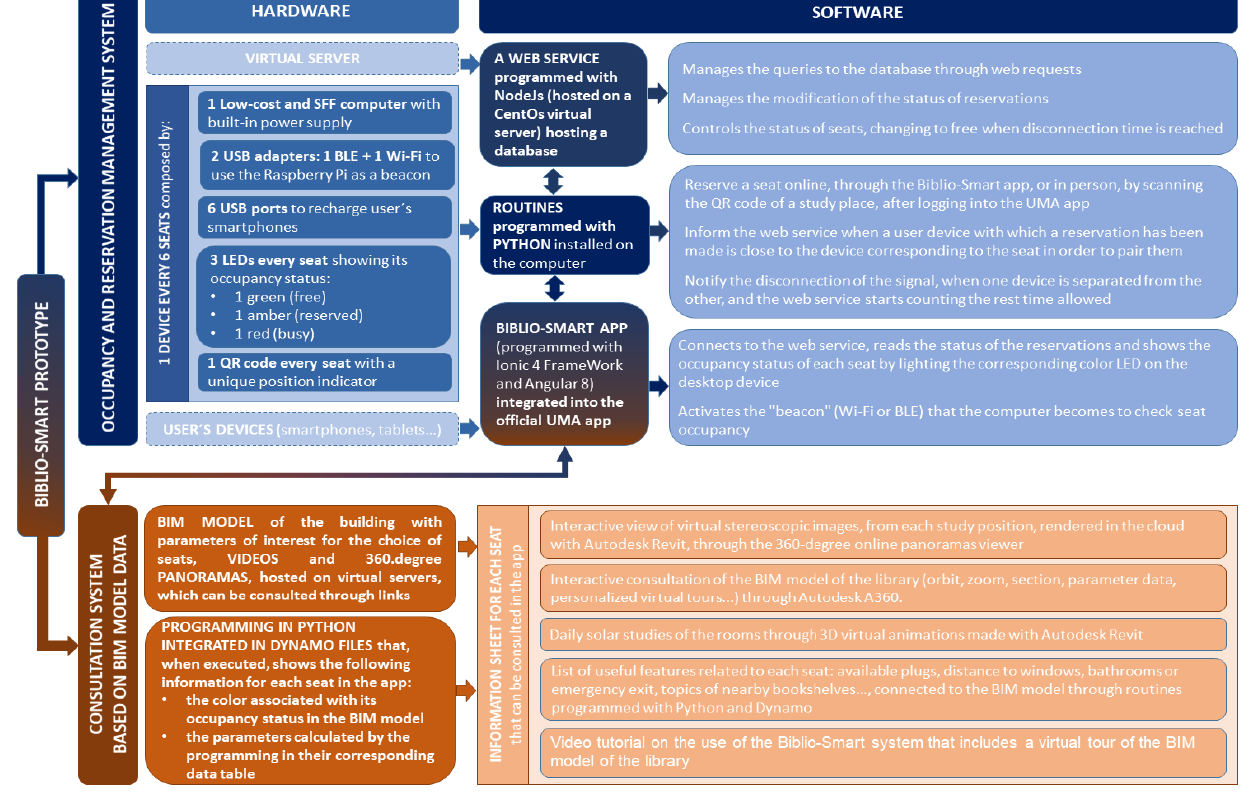
Figure 1. Diagram of the Biblio-Smart prototype components and the functions managed by each one.